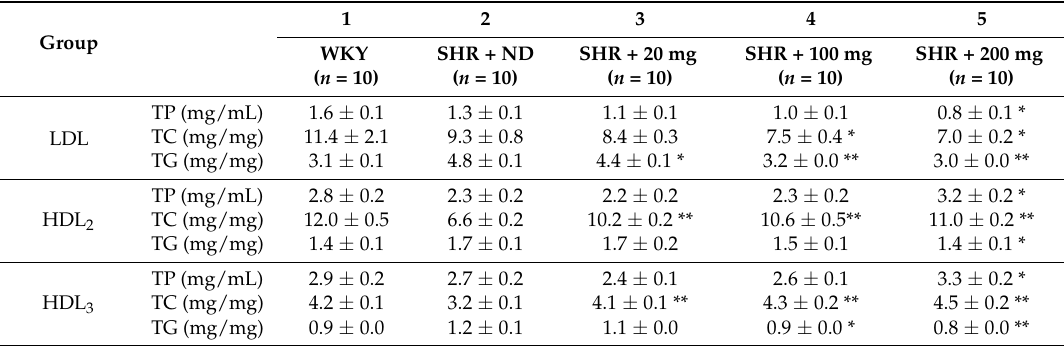
Table 3. Lipid and protein compositions in lipoprotein profile at week 8.